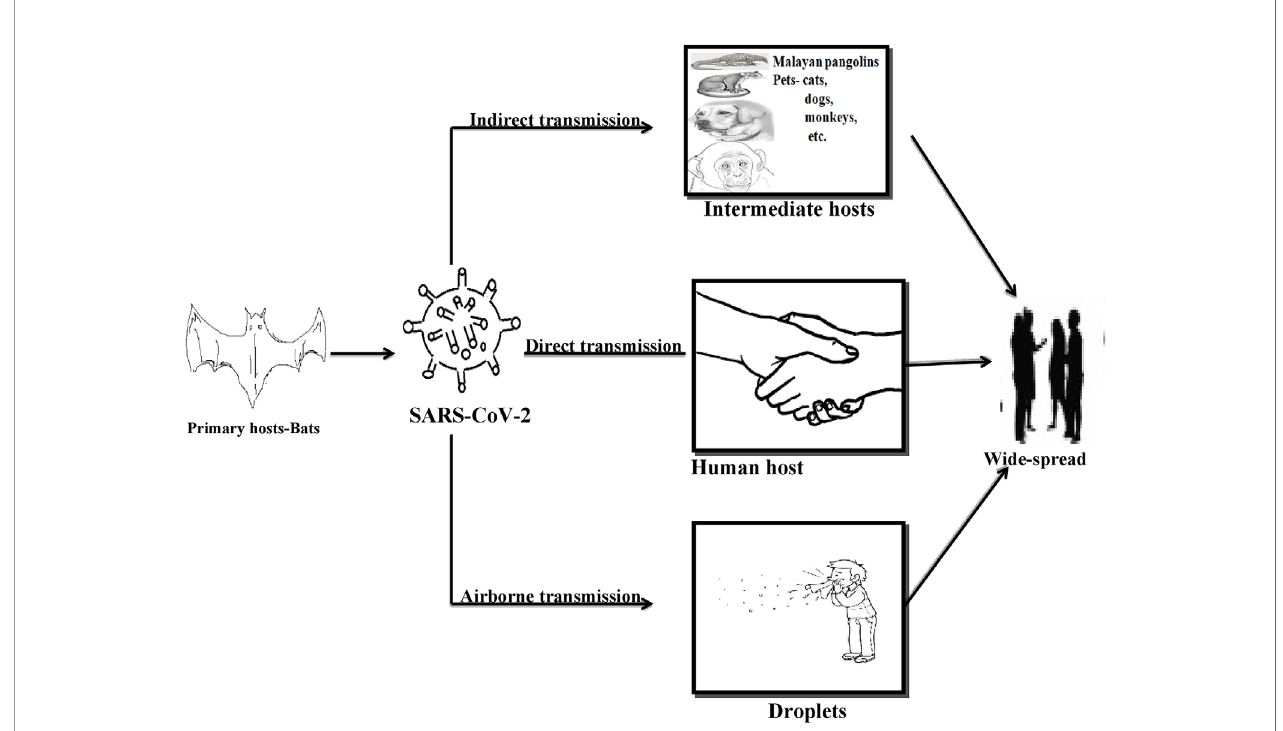
FIGURE 1 | The potential hosts and possible routes of SARS-CoV-2